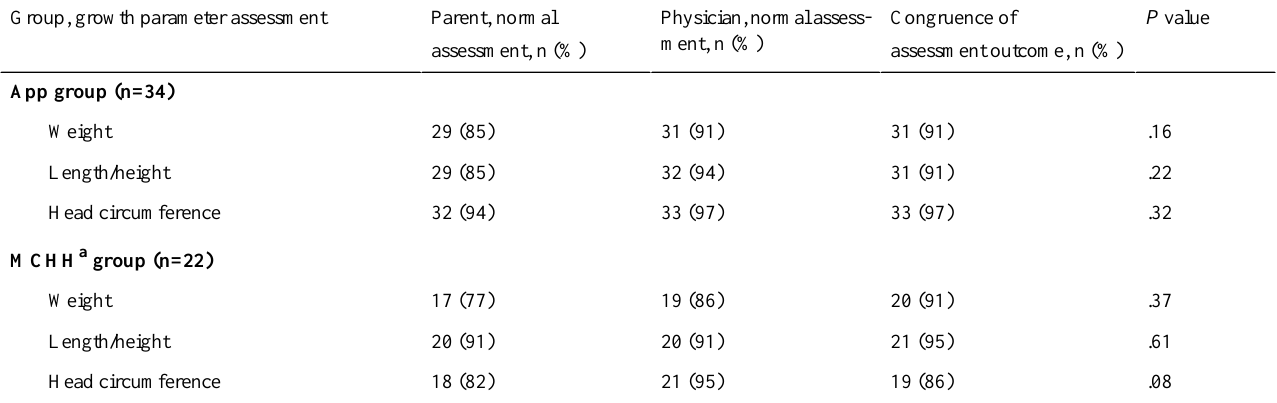
Table 3. Congruence of child growth assessments between parents and physicians by group.